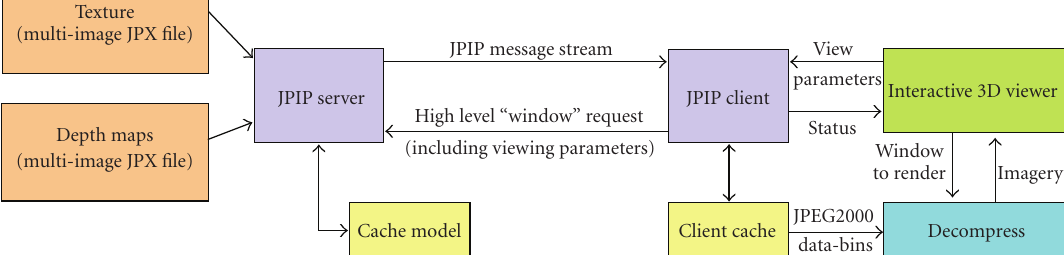
Figure 5: Architecture of the transmission system.